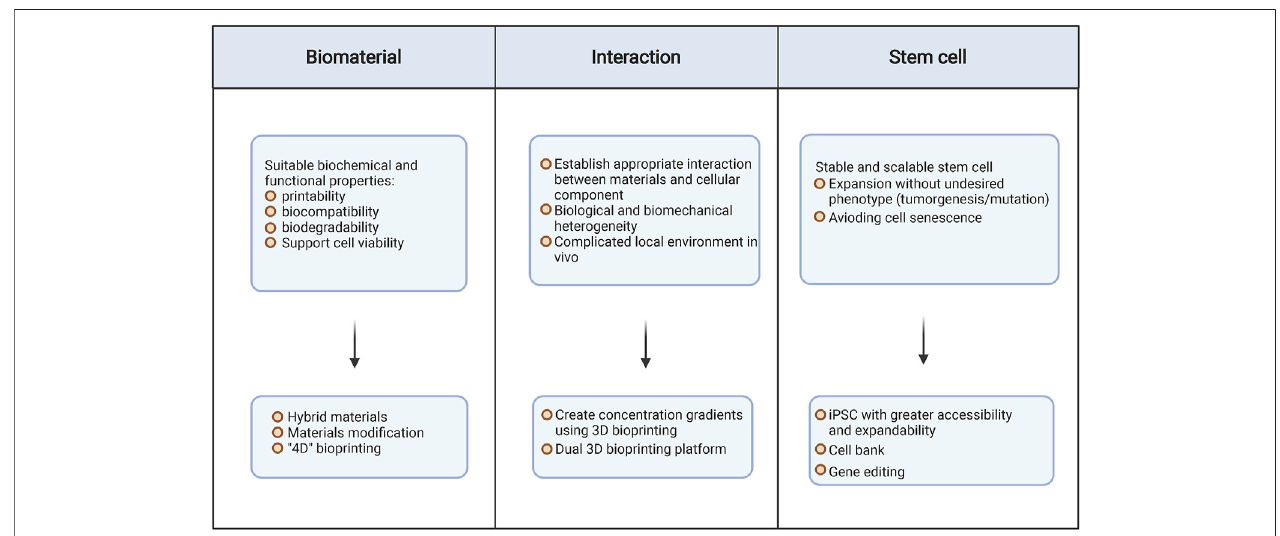
FIGURE 4 | Current challenges and solutions for bone and cartilage tissue